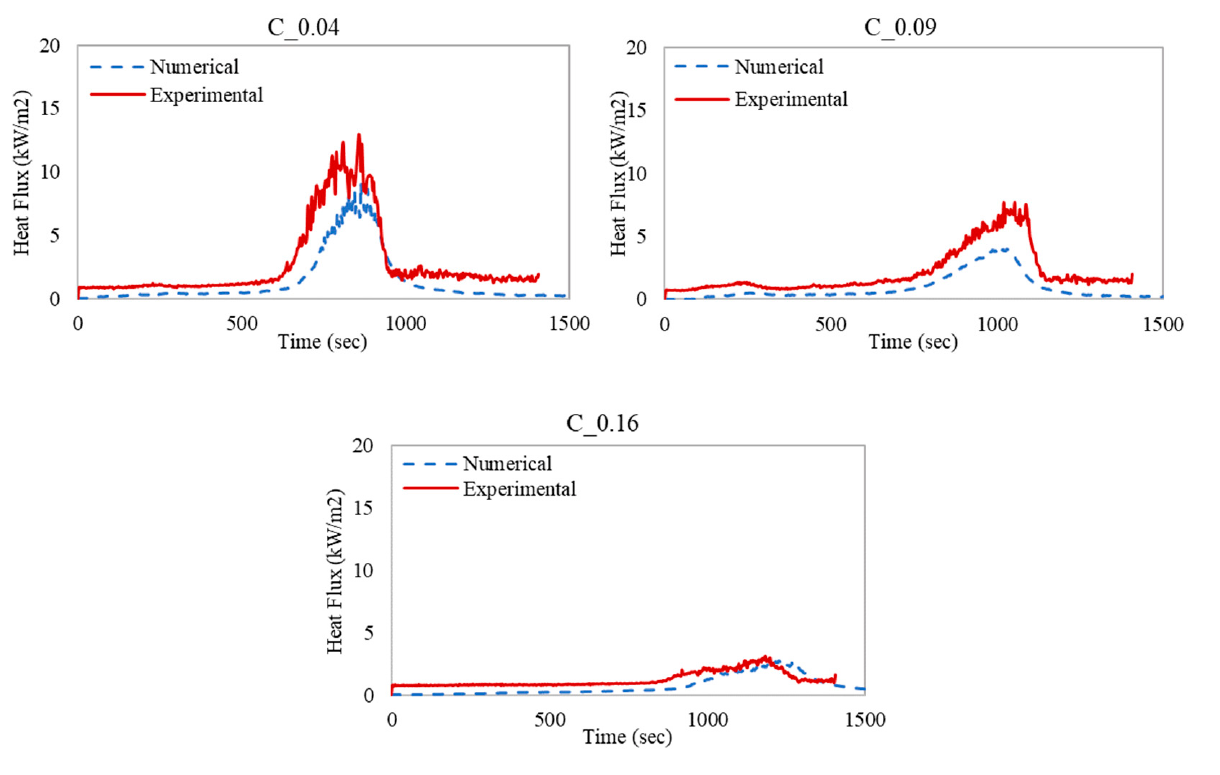
Figure 20. Radiative heat flux (corner cases).